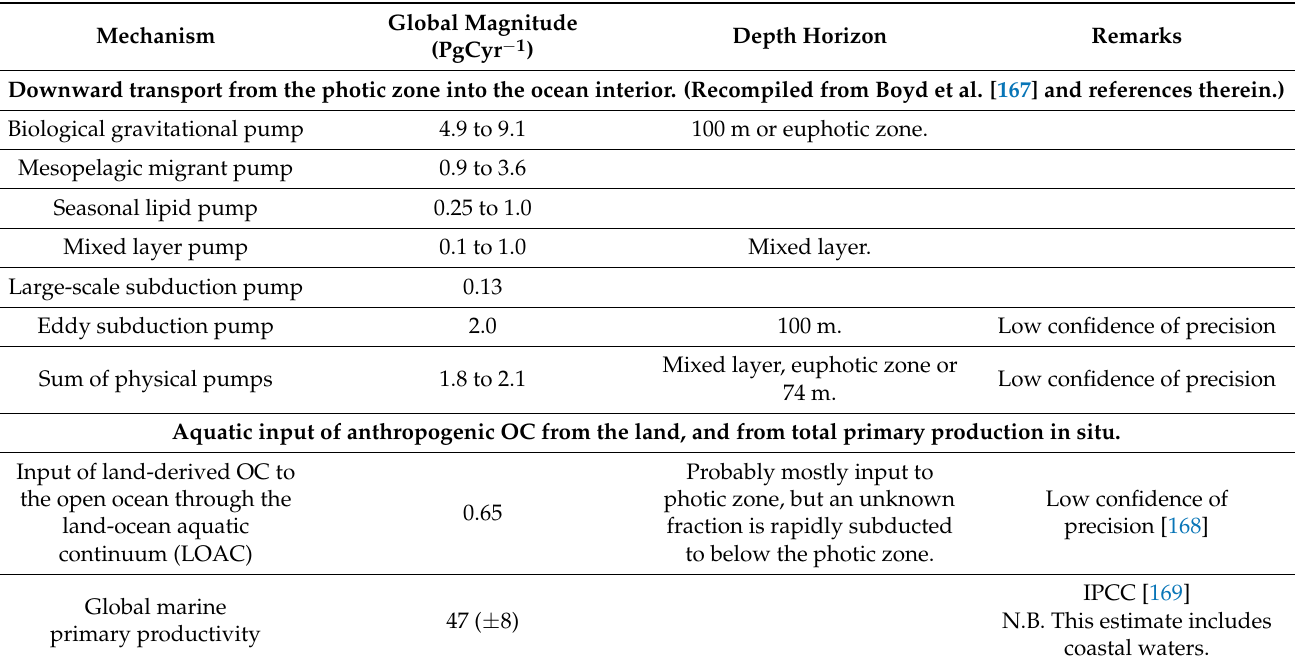
Table 3. Synthesis of major inputs of organic matter to the open